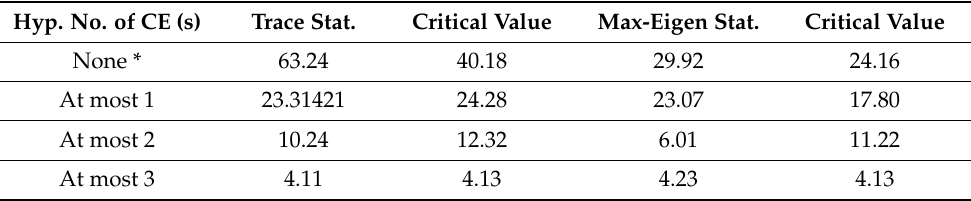
Table 5. Results of the Johansen Cointegration Test for Health Outcomes (Life Expectancy). Hyp. No. of CE (s) Trace Stat. Critical Value Max-Eigen Stat. Critical Value None * 88.83 40.18 69.56 24.16 At most 1 19.27 24.28 13.35 17.80 At most 2 5.92 12.32 11.22 At most 3 0.01 0.01 4.13